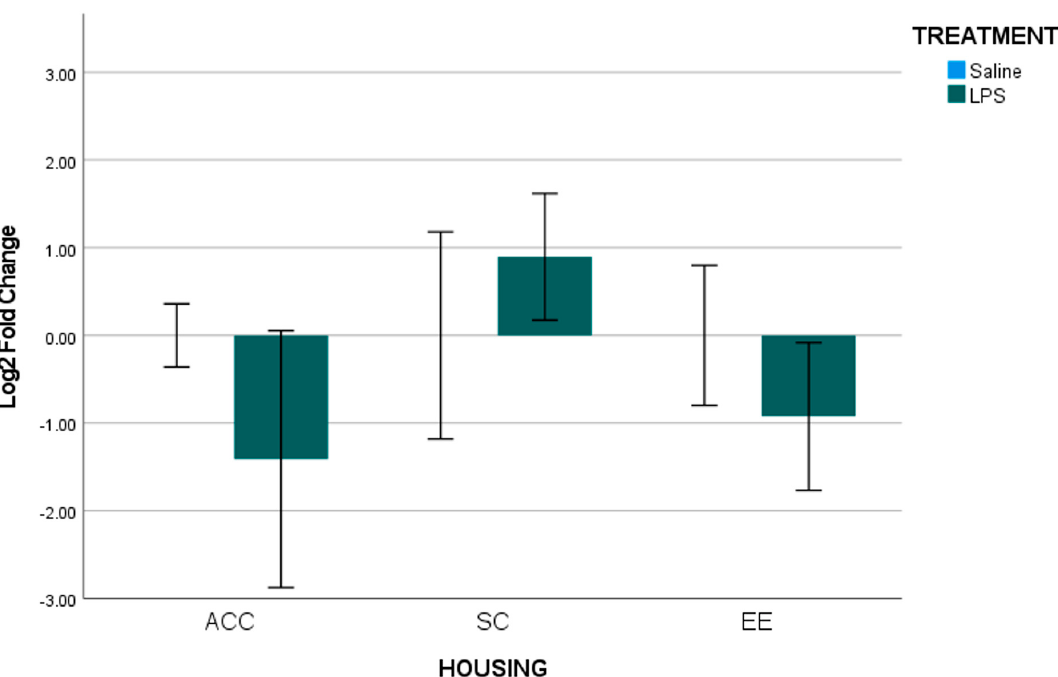
Figure 3. B2 SINE expression for Standard vs. Enriched and Standard vs. Social Control Housing in the NAcc. Standard (Saline: n = 12, LPS: n = 10), Enriched (Saline: n = 12, LPS: n = 14), Social Control (Saline: n = 13, LPS: n = 15). A two-way ANOVA revealed there were no simple main e ff ects from housing or treatment. There were no statistically signi fi cant interactions. (* p ≤ 0.05, a p < 0.05, main e ff ect of treatment, b p < 0.05, main e ff ect of housing; mean ± SEM). The medial preoptic area, which has a role in physical responses and the relaying of stress response pathway [81], was also chosen to be examined. In MPOA, there was no interaction e ff ect (F (2, 75) = 0.405, p = 0.668), no e ff ect of treatment (F (1,75) = 0.305, p = 0.582), and no e ff ect of housing (F (2,75) = 0.405, p = 0.668) (Figure 4).